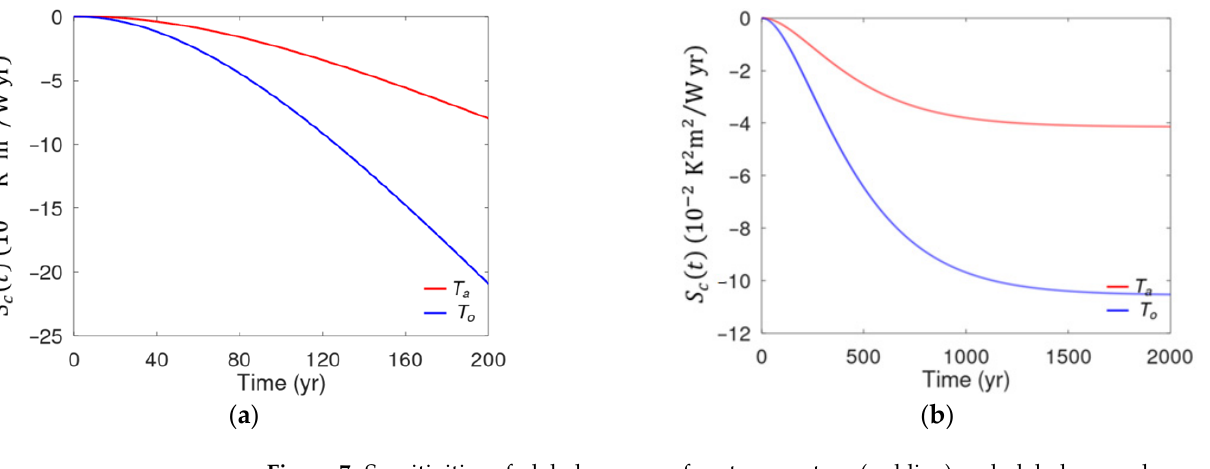
Figure 6. Sensitivities of global mean surface temperature (red line) and global mean deep ocean temperature (blue line) with respect to parameter 𝐶 (cid:3028) , calculated for linear forcing: ( a ) over time interval 0–200 years, ( b ) over time interval 0–2000 years.